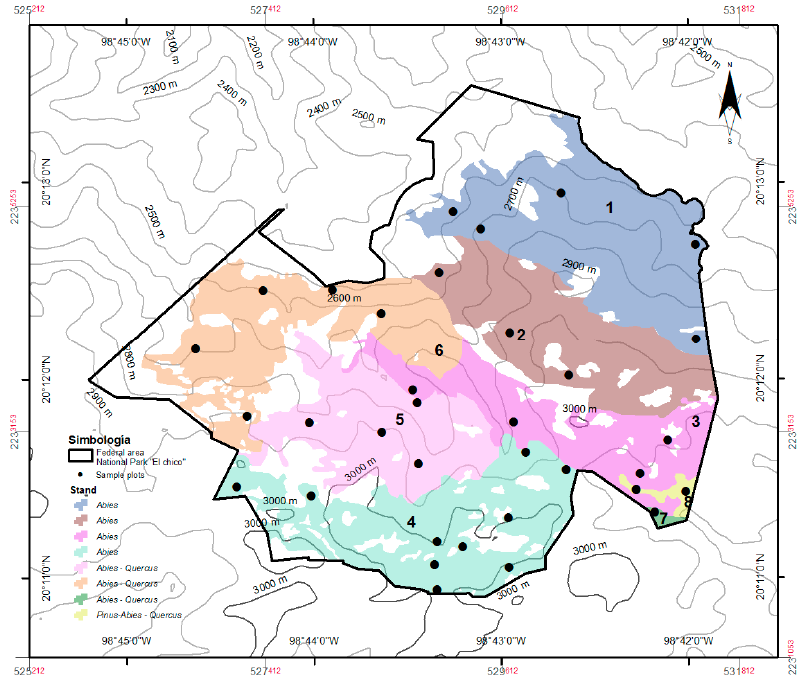
Figure 2. Forest zoning obtained through the analysis of satellite images in combination with altitude information, orientation, and slope.